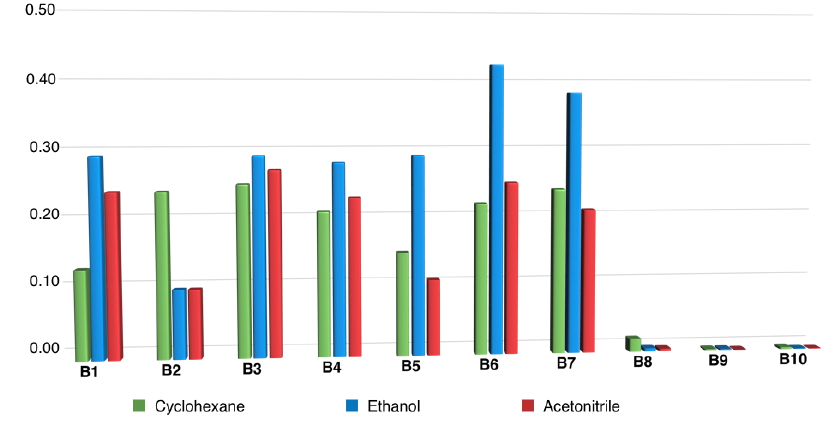
Figure 2. Fluorescence quantum yields of compounds B , highlighting the very low native fluorescence of N- aryl derivatives B8 – B10.